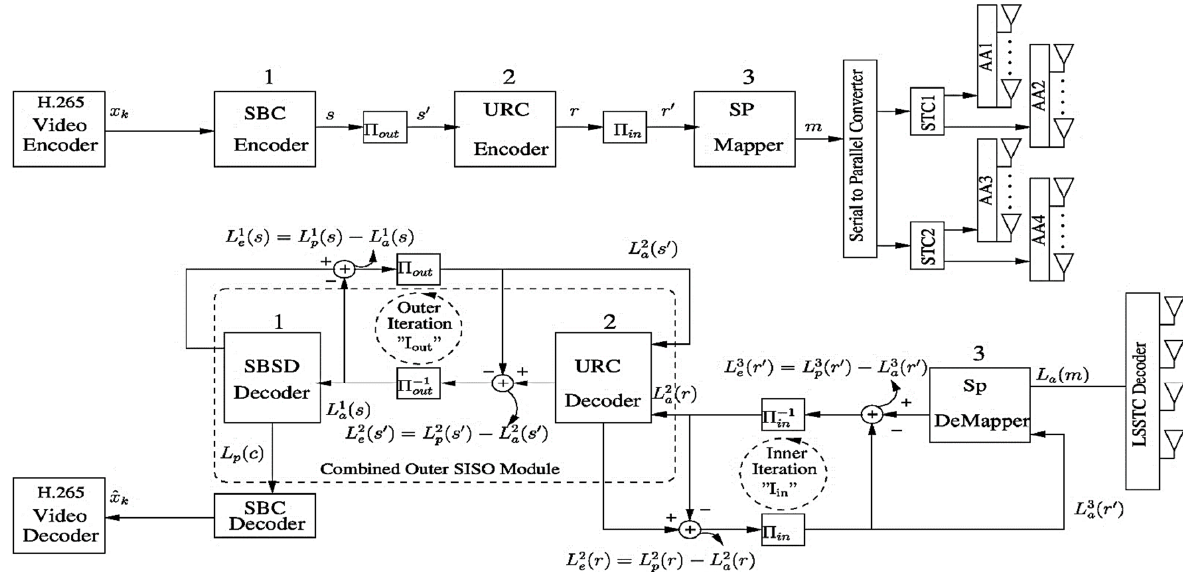
Figure 1. Block diagram of the three-stage LSSTC scheme with iterative JSCD system. The information bits are initially encoded by the HEVC encoder, and the data are compressed to an extent suitable for limited bandwidth transmission.